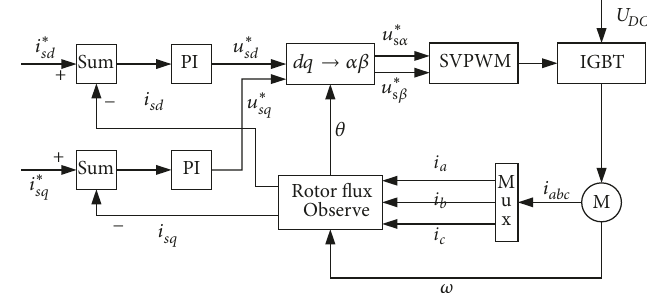
Figure 3: RFOC: rotor flux oriented control.